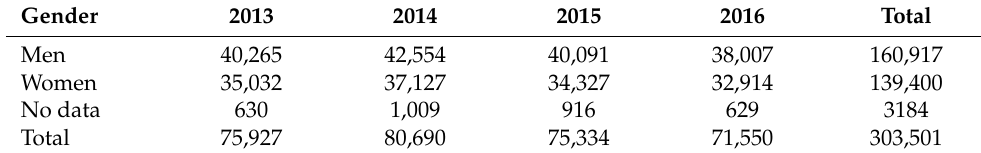
Table 2. Number of admissions in the Emergency Room (ER) divided for gender.